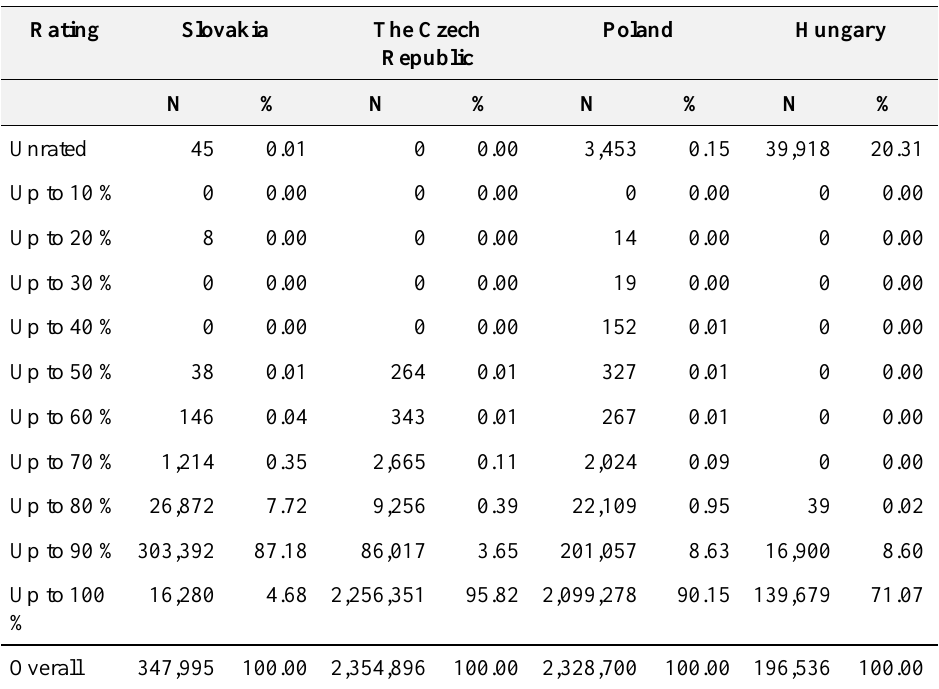
Table 3 – Total number of customers evaluating e-shops Rating